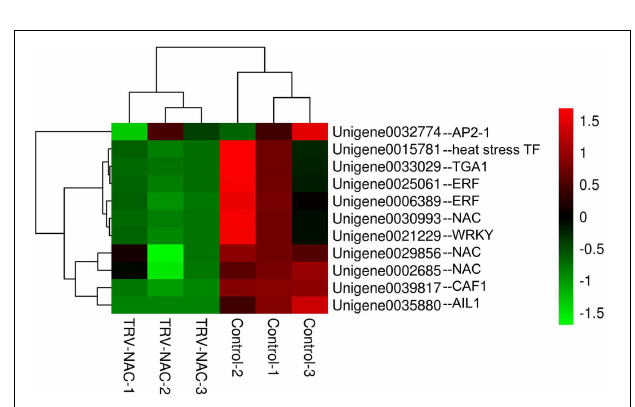
FIGURE 8 | Heatmap analysis of the downregulated transcription factor (TF) in GO:0034645. Data were normalized to Z -score.